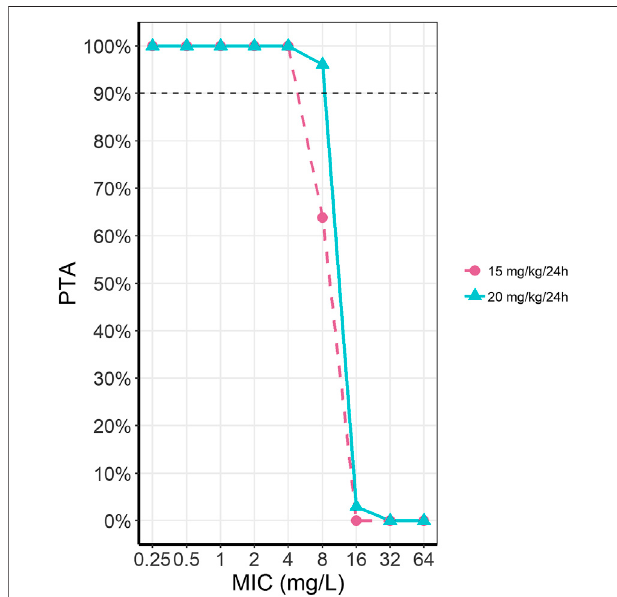
FIGURE 4 | Probability of target attainment (PTA) for amikacin for two dosing regimens at different MICs. The two presented dosing regimens are thecurrentDPFrecommendationof15 mg/kg/24 h(pink,dashedline,circles) and our optimally simulated dose of 20 mg/kg/24 h (light blue, solid line,